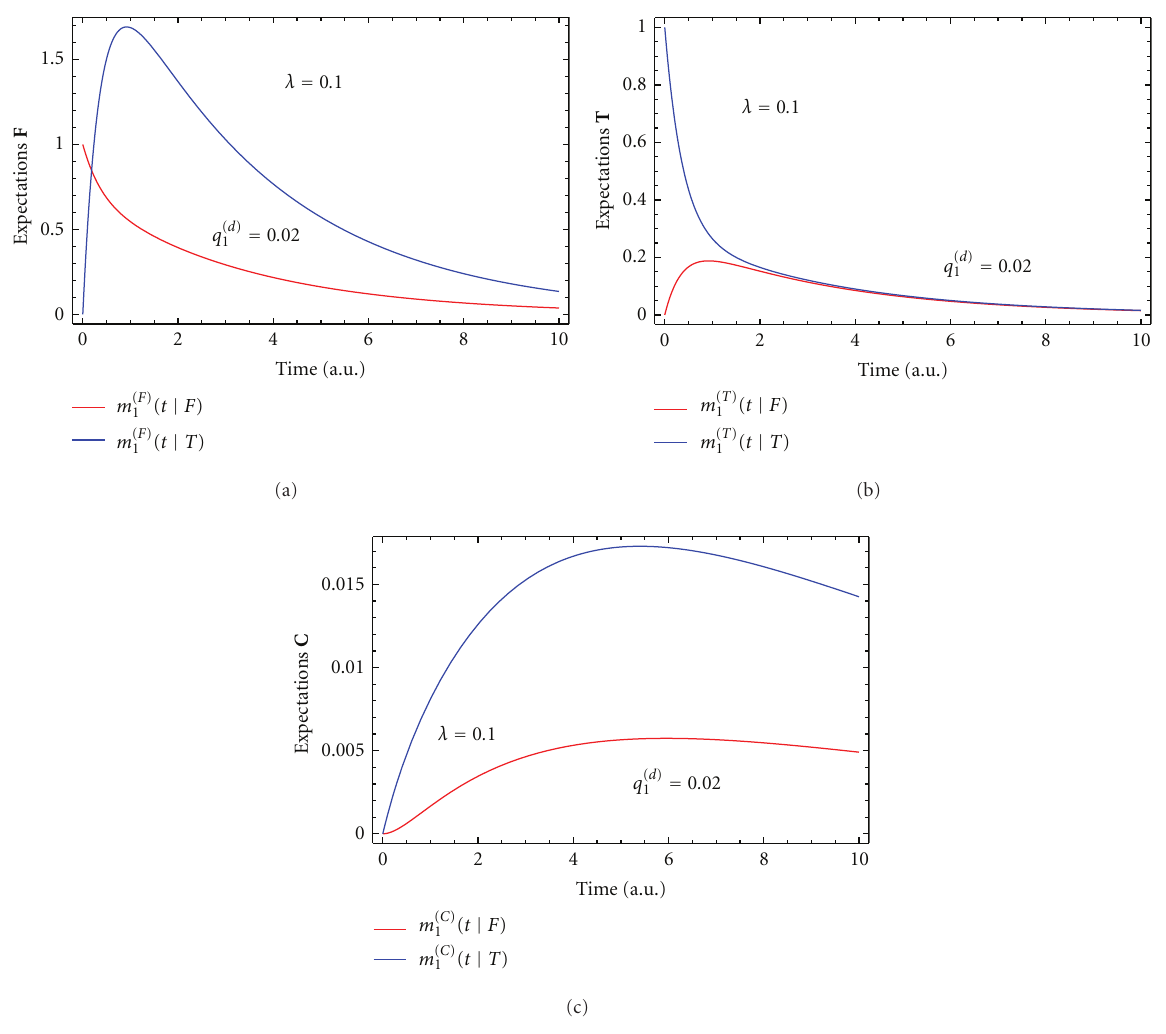
Figure 3: Dependence of the expectations of the numbers of particles of types F, T, and C on the time, assuming that the starting particle was either F or T